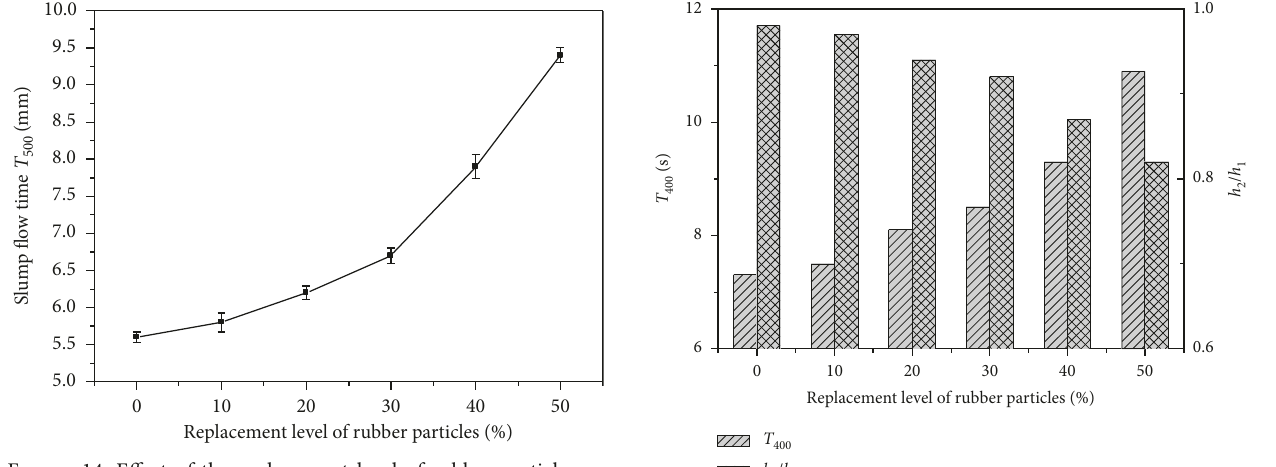
Figure 14: Effect of the replacement level of rubber particles on slump flow time T 500 .